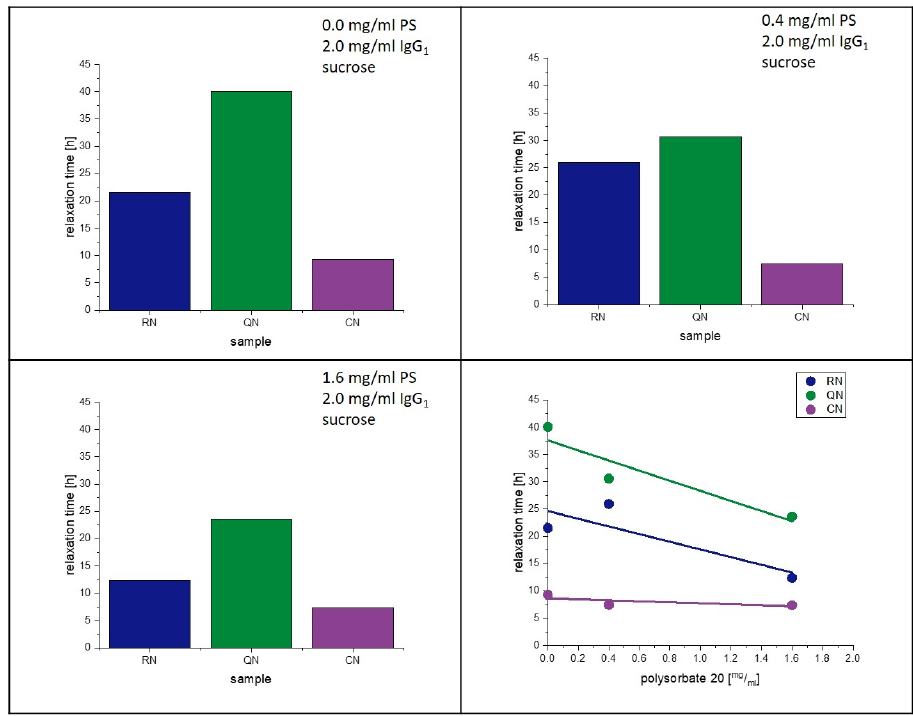
Figure 12. Influence of polysorbate on relaxation at 25 °C.